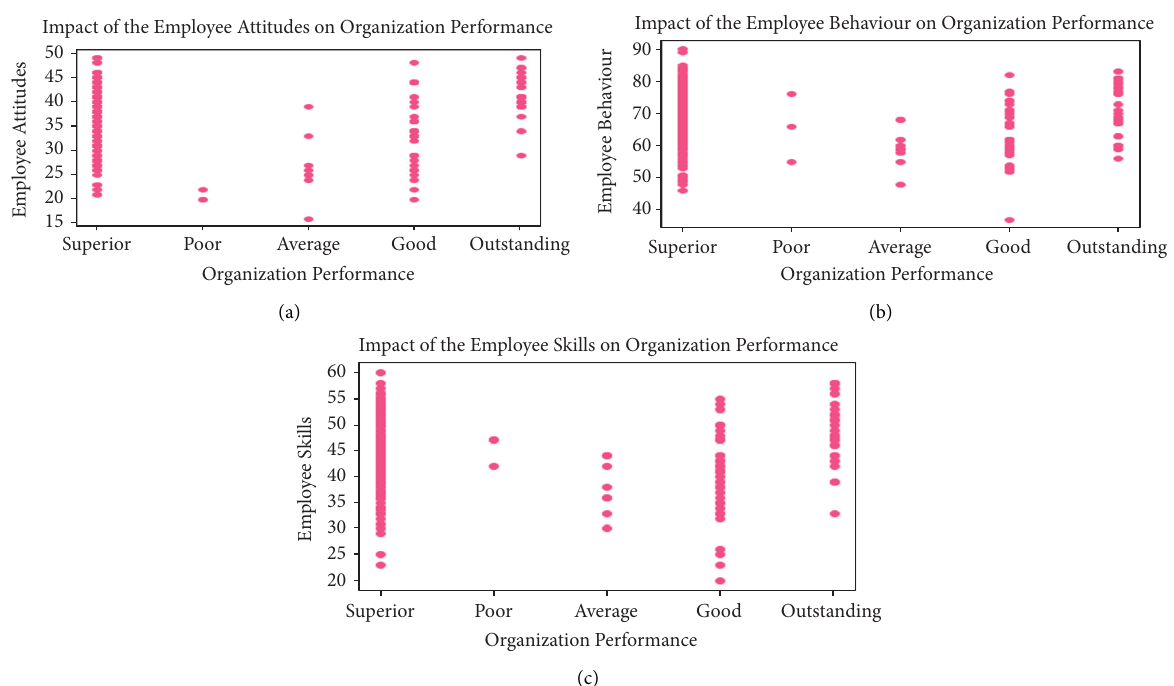
Figure 3: Impact of human resource outcomes (employee attitude, behavior, and skills) on bank industry performance. (a) Employees attitude. (b) Employees behavior. (c) Employees